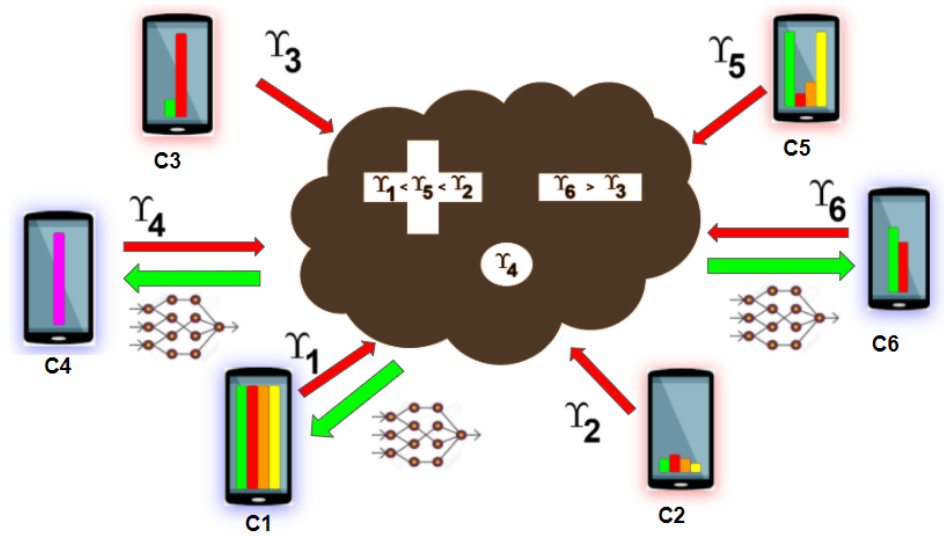
Figure 5. Non-IID condition ( N o = 5). No client has all categories. Sampling the best 3 out of 6 clients with α = β = γ .